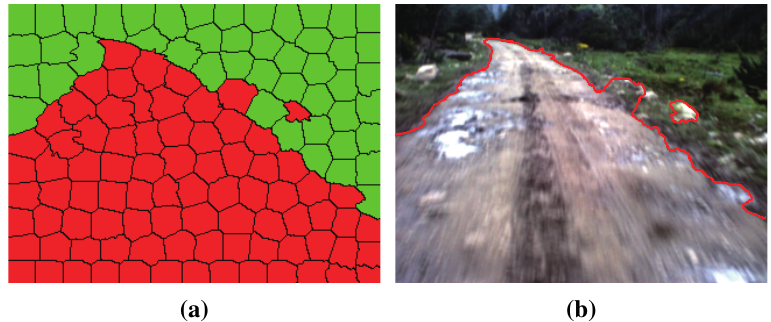
Figure 13. Problems with initial road segments obtained by GrowCut: ( a ) the convergence of the iteration; ( b ) the contour of road